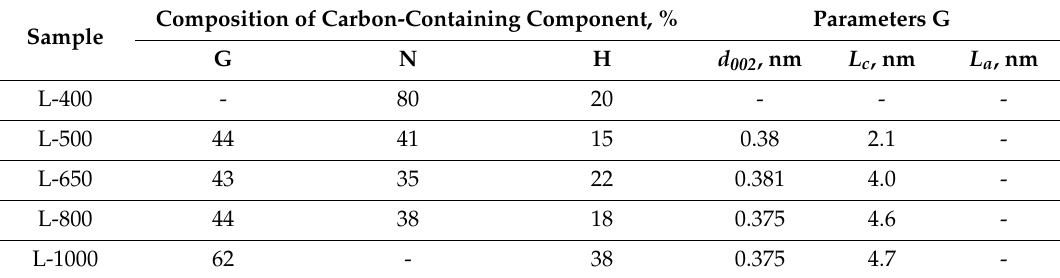
Table 3. X-ray phase composition and X-ray diffraction characteristics of graphite-like phase of rice husk hydrolytic lignin carbonization products